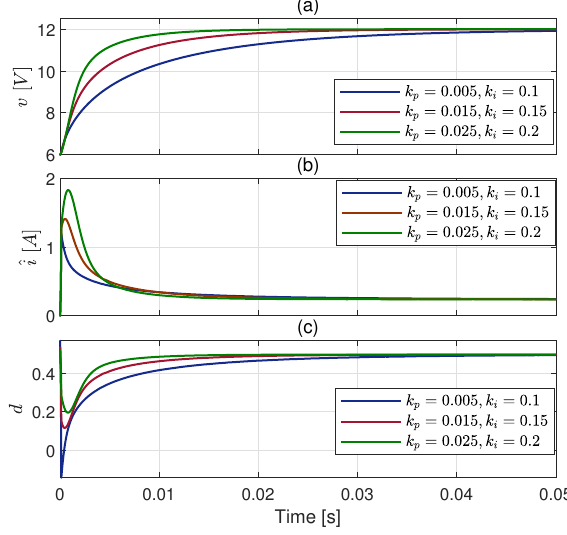
Figure 4. Boost converter transient under the proposed sensorless controller. ( a ) Output voltage v , ( b ) estimated current ˆ i , ( c ) duty ratio d .